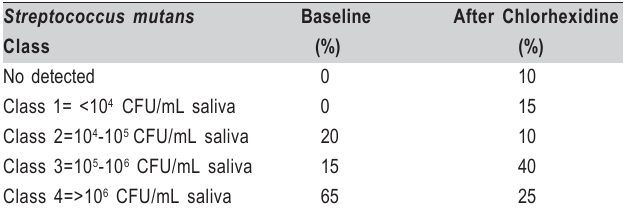
Table 4. Distribution of S. mutans before and after use